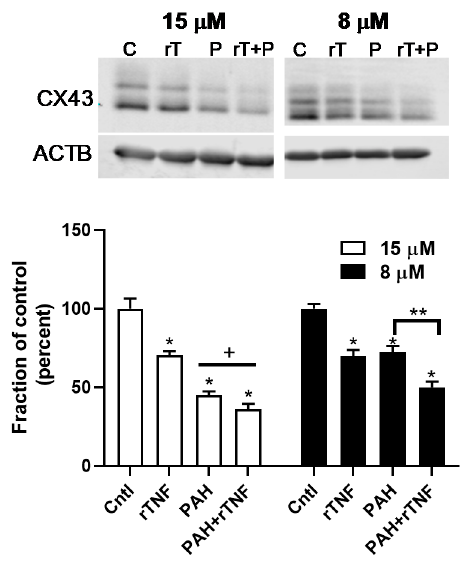
Figure 10. rTNF-induced repression of CX43 protein expression at 24 h is enhanced following co-exposure to rTNF and the lower LMW PAH dose (8 µ M). Both the high (15 µ M) and low (8 µ M) doses of the LMW PAH mixture (1:1 ratio of 1-methylanthracene and fluoranthene) were used to evaluate the e ff ect of rTNF on CX43 protein expression using immunoblots. CX43 protein expression (upper blot) is normalized to bactin (lower blot). rTNF (1 ng / mL), LMW PAHs at both doses, and the combinations of both doses with rTNF are shown. The immunoblot depicted at the top is representative of 3 experiments with an n = 3 per treatment group per experiment. * p < 0.05 all treatments compared to the control (DMSO); + p < 0.05 rTNF compared to 15 µ M PAH or rTNF plus 15 µ M PAH; ** p < 0.05 8 µ M PAH plus rTNF compared to either rTNF or 8 µ M PAH alone. C, Cntl, control (DMSO); rTNF, rT, recombinant TNF (1 ng / mL); PAH, P, LMW PAH mixture; rT + P, rTNF plus PAH